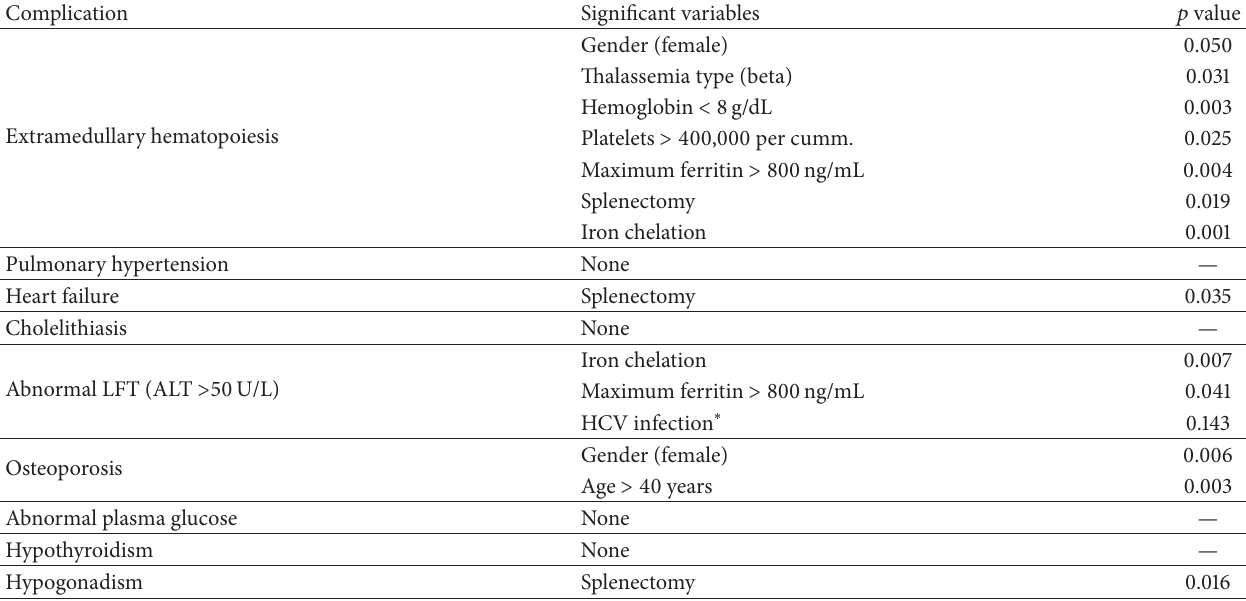
Table 4: Significant risk factors affecting complications from univariate analysis.